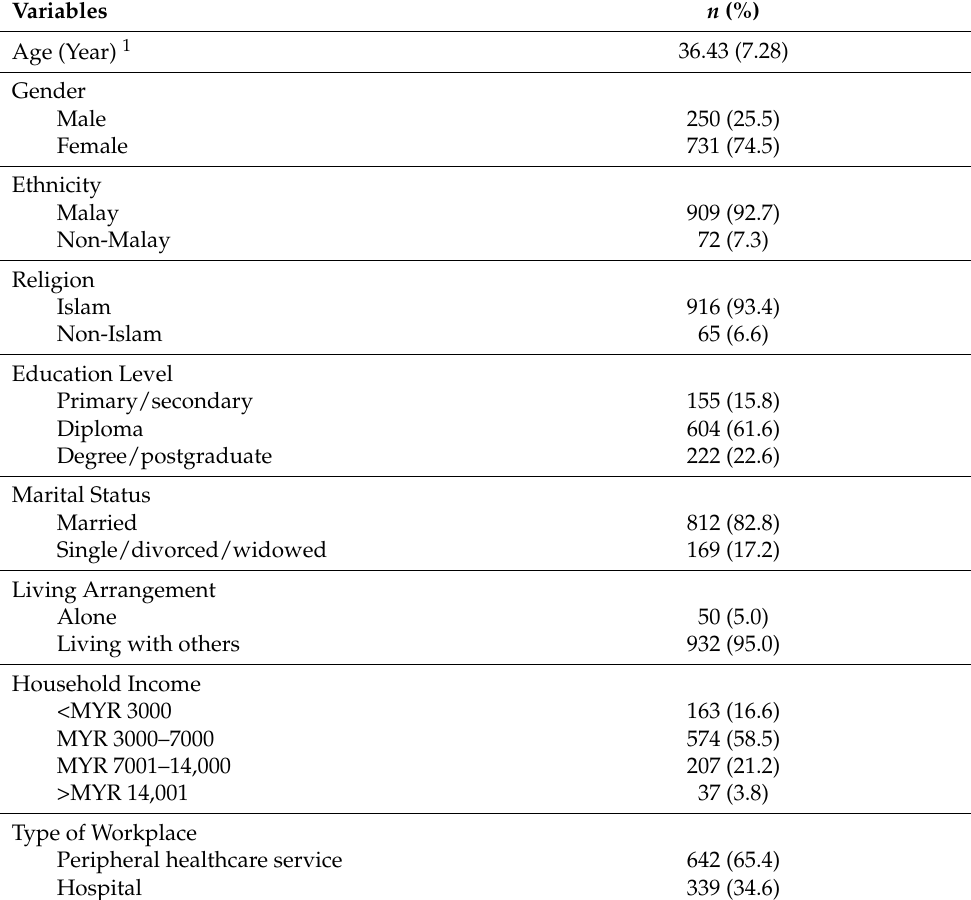
Table 1. Sociodemographic, occupational, and health characteristics of respondents ( n =